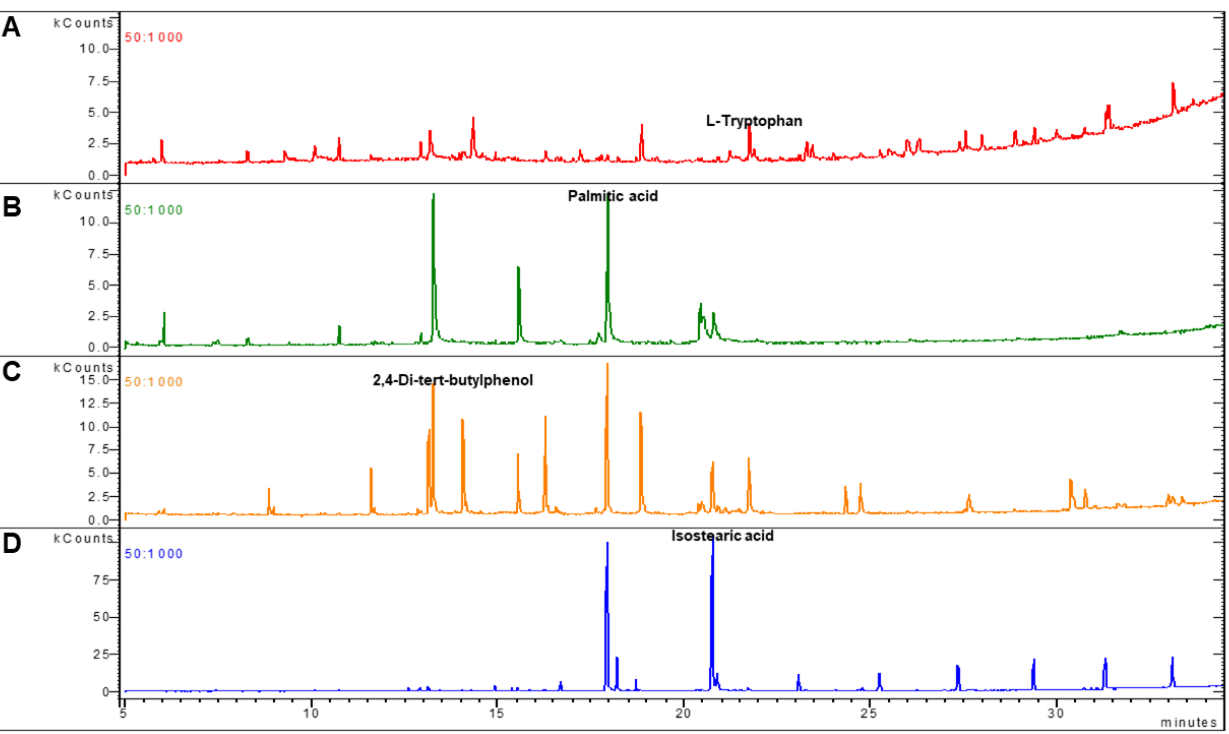
Figure 5. GC/MS chromatograms (TIC) of the best predictor metabolites: l-Tryptophan ( A ), Palmitic acid ( B ), Butylphenol ( C ), and Isostearic acid ( D ). Agilent GC 7890B–MS240 ion trap gas chromatography (GC) technology equipped with MS detector. Metabolites were isolated through an HP-5MS capillary 54 column (30 m × 0.250 mm i.d.; 0.25-µm film thickness; Agilent J&W Scientific).